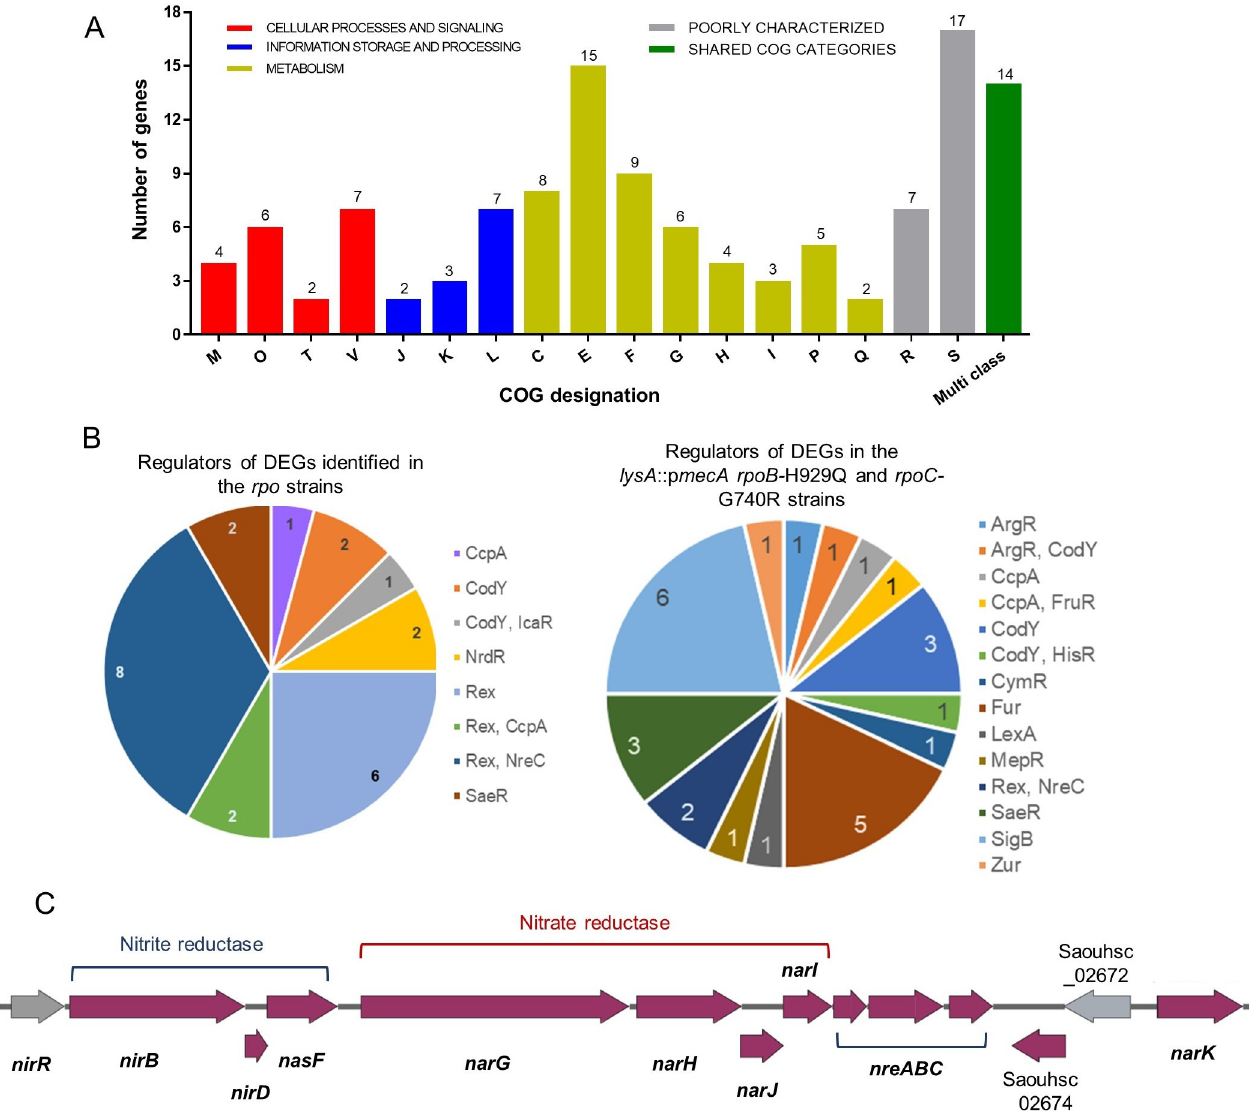
Fig 7. Functional classification and transcriptional regulation of common genes. A) COG (Clusters of Orthologous Groups) classification of 121 overlapping DEGs. Colours illustrate COG functional categories. C, Energy production and conversion; E, amino acid transport and metabolism; F, nucleotide transport and metabolism; G, carbohydrate transport and metabolism; H, coenzyme transport and metabolism; I, lipid transport and metabolism; P, inorganic ion transport and metabolism; Q, secondary metabolites biosynthesis, transport, and catabolism; M, cell wall/membrane/envelope biogenesis; O, post-translational modification, protein turnover, and chaperones; T, signal transduction mechanisms; V, defence mechanisms; J, translation, ribosomal structure and biogenesis; K, transcription; L, replication, recombination and repair; R and S are function prediction only or function unknown categories. Total number of genes associated with each category are listed outside the bar. B) The transcriptional regulators were predicted for 24 out of 26 and 95 common DEGs identified in the three rpo strains compared to their parent (Fig 6D). C) Chromosomal region of the genes involved in nitrite and nitrate reduction in S . aureus . A membrane bound nitrate reductase system ( narGHJI ) reduces nitrate to nitrite. Subsequently, nitrite is reduced to ammonia by NADH-dependent nitrite reductase system ( nirBD ) [53]. NreABC has been identified as an oxygen sensing system which regulates the expression of nitrate and nitrite reductase system as well as narK